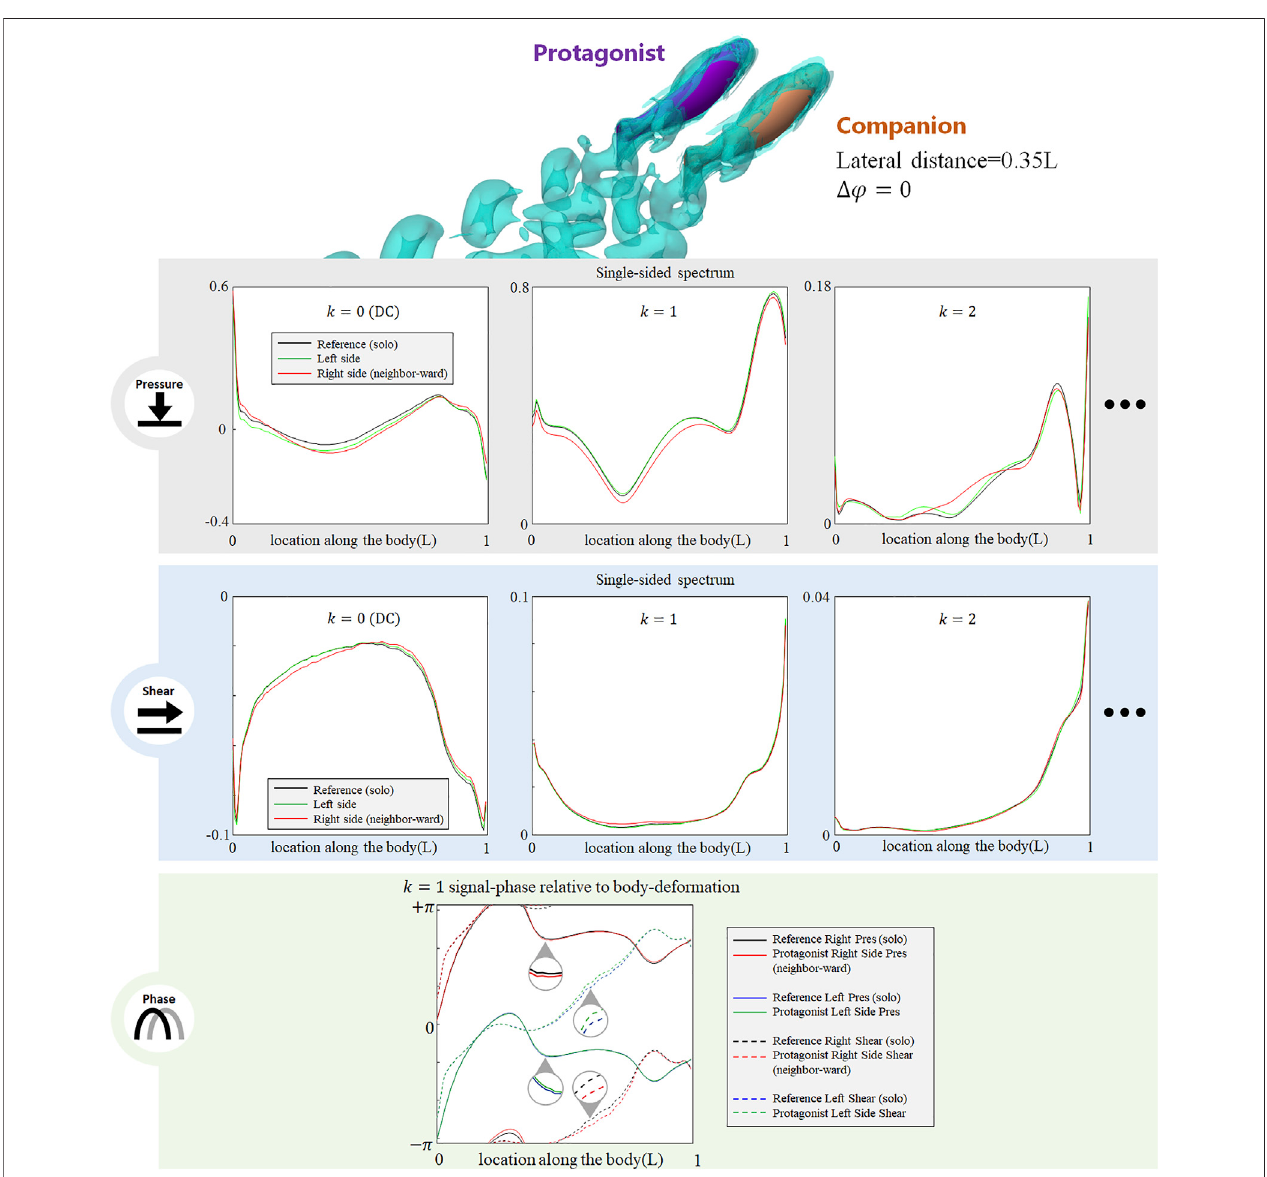
FIGURE 3 | Signal features sensed by the protagonist fi sh when an alongside, in-phase neighbor is 0.35 L away on its right side. Full results are presented in Supplementary Figure S1 , ESM. One stress unit = 10 Pa.